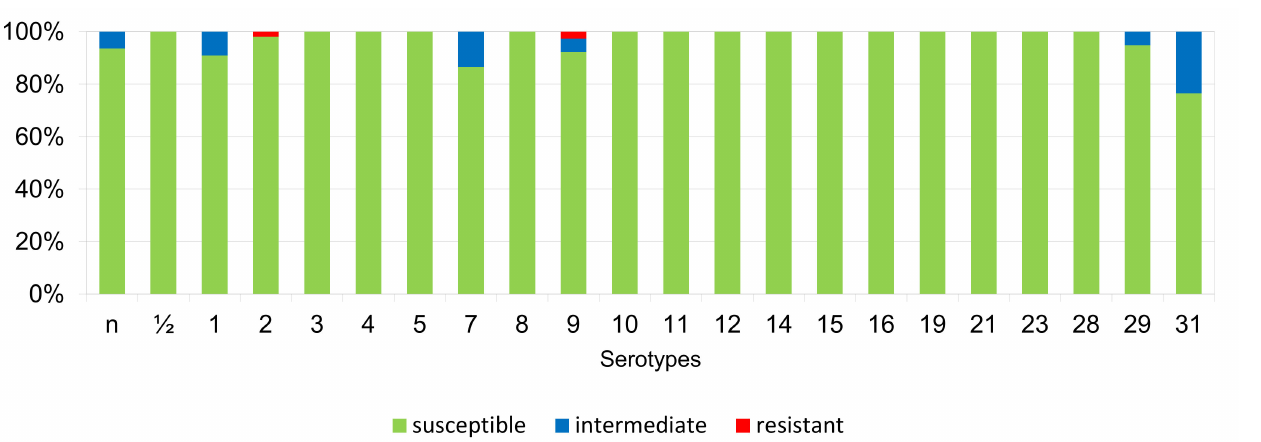
Figure 7. Percentage representation of isolates resistant, intermediately resistant, and susceptible to ampicillin belonging to individual S. suis serotypes from the Czech Republic during 2018–2022 ( n = 506). n = non-typeable isolates.